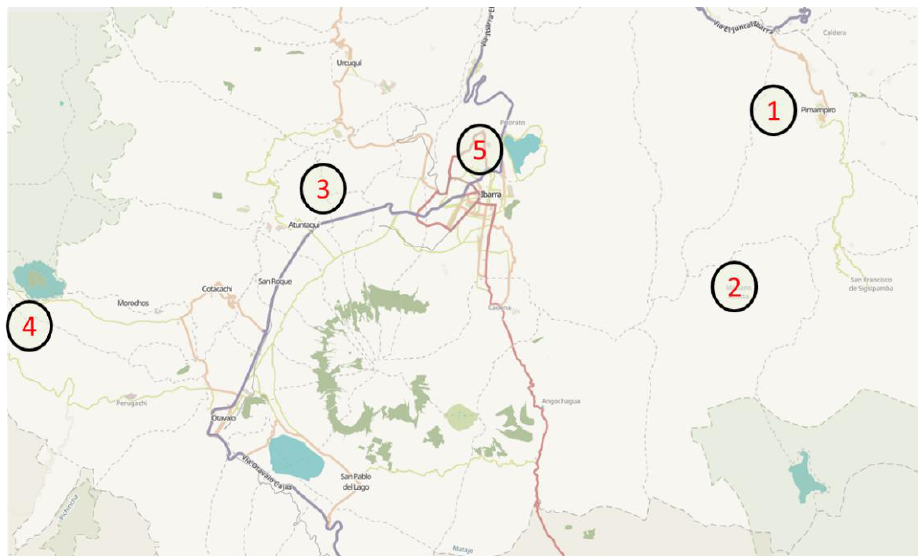
Figure 1. Geographic location of five apiaries in the province of Imbabura (Ecuador). 1: Apiary El